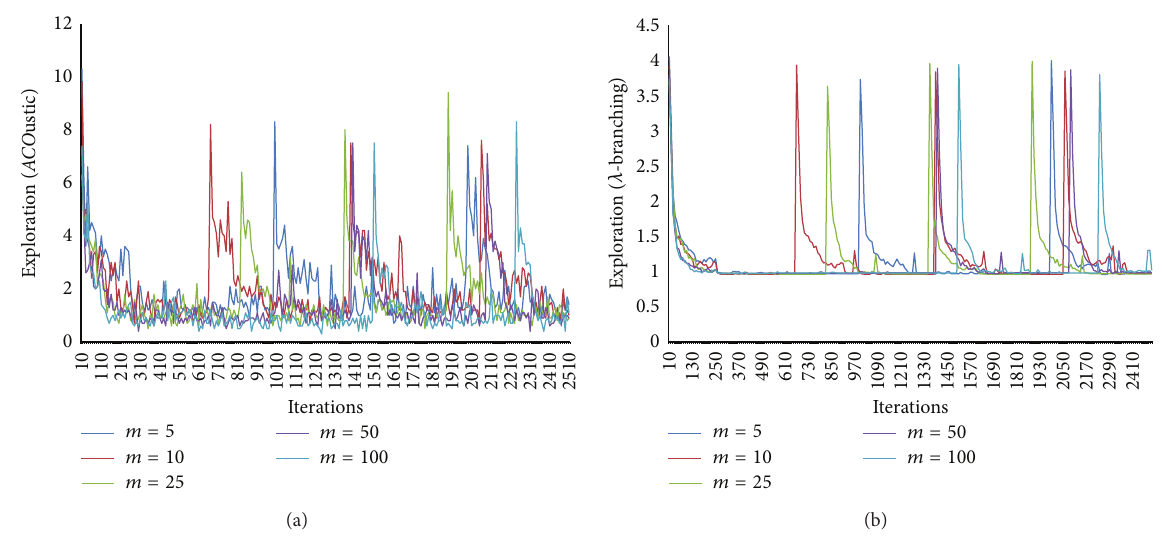
Figure 13: The effect of number of ants ( 𝑚 ) measured by ACO ustic (a) and measured by 𝜆 -branching